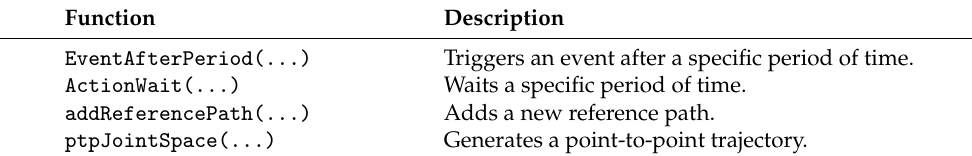
Table 3. Modia3D actions. For applications, see Section 6. Function